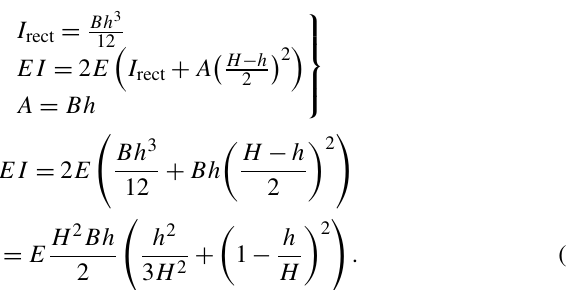
Fig. 3 for the variable definitions) as follows: